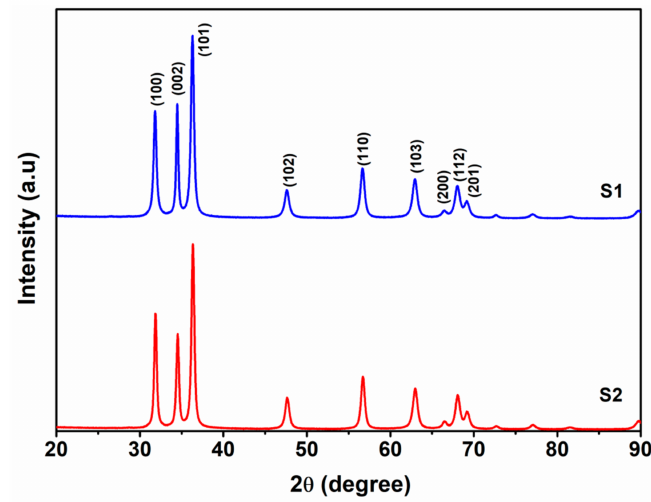
Figure 1. XRD patterns of ZnO/graphene